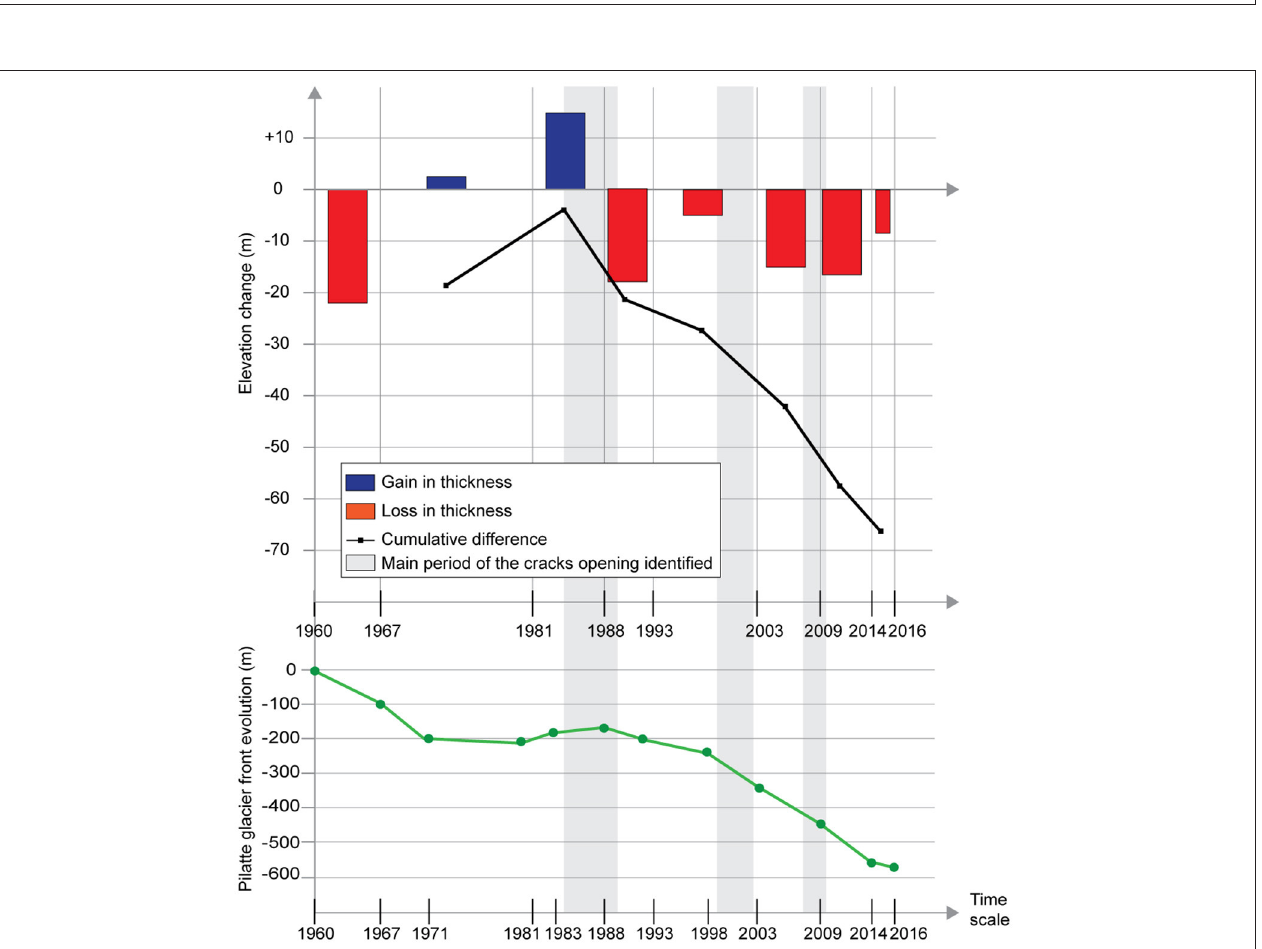
FIGURE 7 | Glacier surface evolution downstream from the Pilatte rock slope, and retreat of the Pilatte glacier over 8 (level) to 11 (front) periods between 1960 and 2016. The three images of 1967, 1983, and 1998 were only used for measuring the glacier front retreat, not for generating 3D point clouds because of snow or clouds during